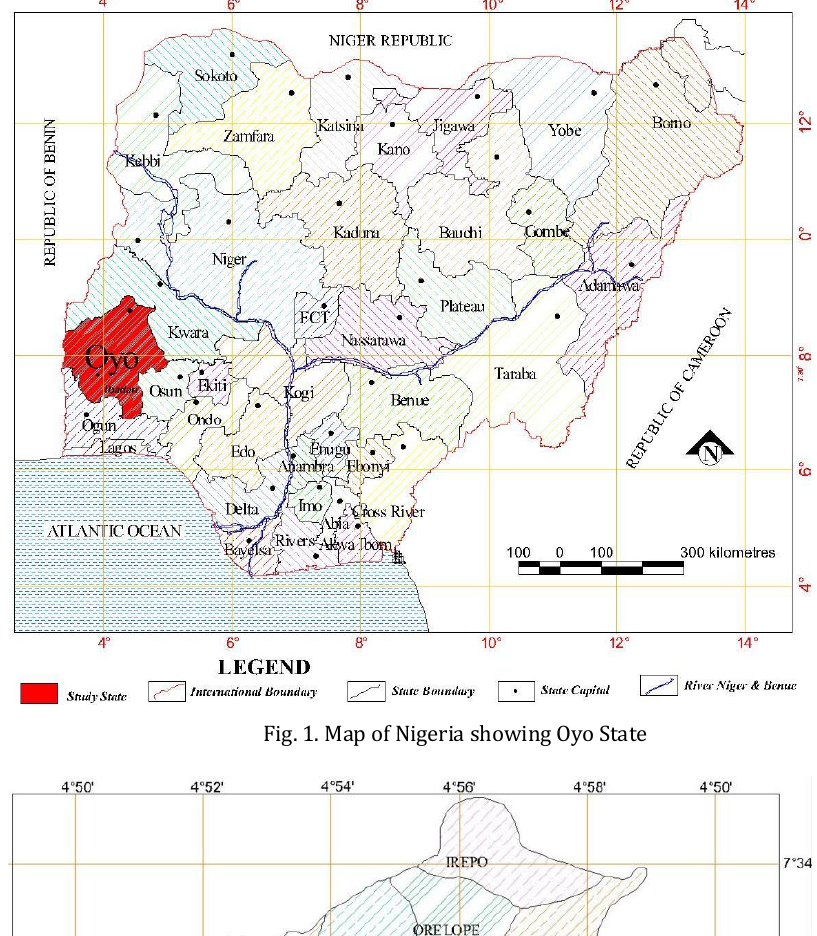
Fig. 1. Map of Nigeria showing Oyo State